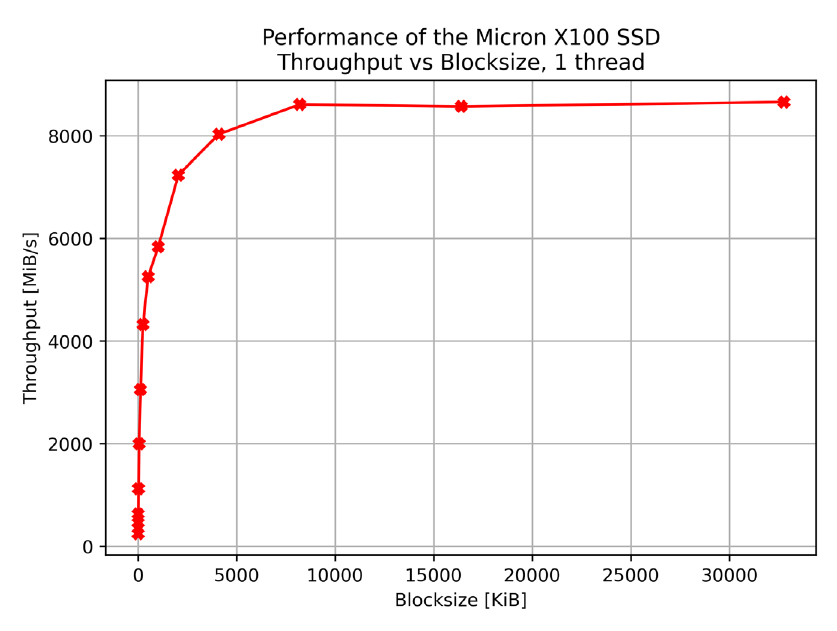
Figure 1. Write throughput as a function of the block size ranging from 4 KiB up to 32 MiB. The system reaches the maximum bandwidth with a block size of around 8